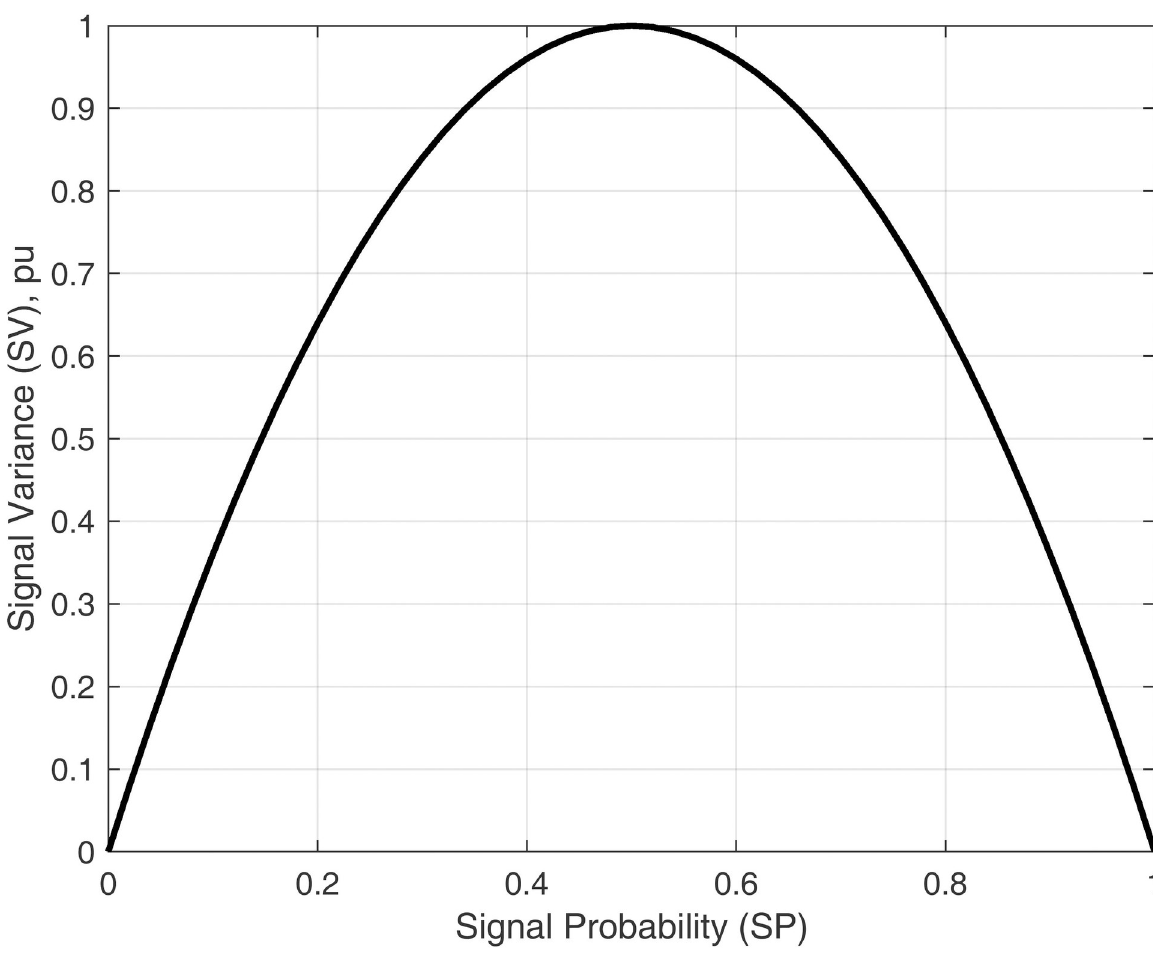
Fig 2. Relationship between signal variance and signal